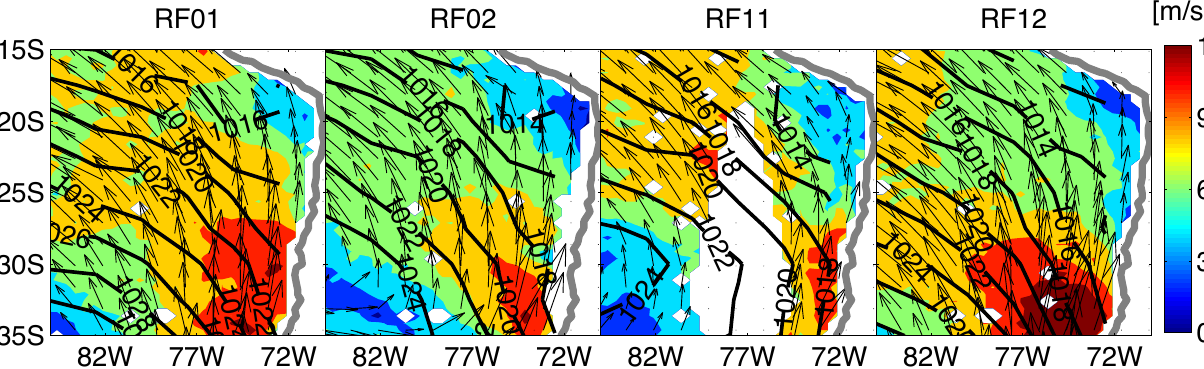
Fig. 1. MODIS-Terra maps for each research flight. (a) N d and (b) LWP. The black solid lines indicate the aircraft track. The thick gray line Figure 1: MODIS-Terra maps for each research flight. a) N represents the coastal line. solid lines indicate the aircraft track. The thick gray line represents the coastal line. 864